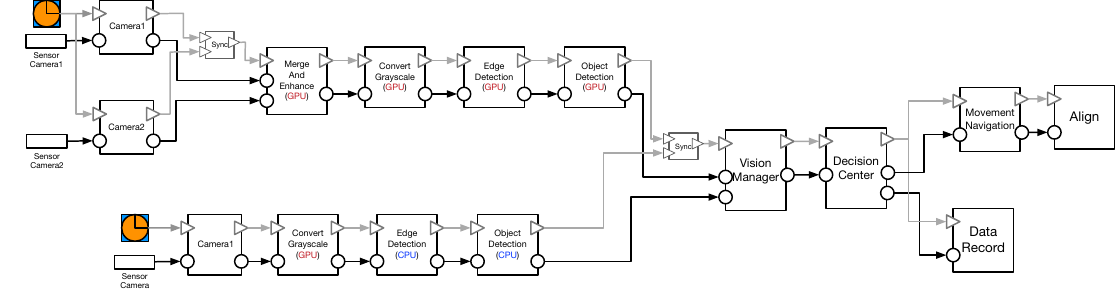
Figure 6. The allocation scheme result with unfolded